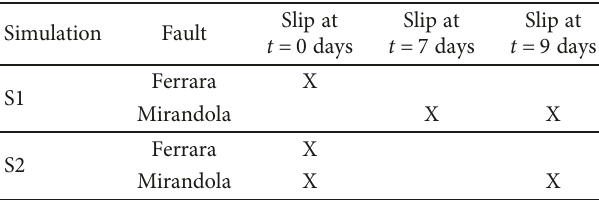
Table 2: Conceptual scheme of fault slip in S1 and S2.